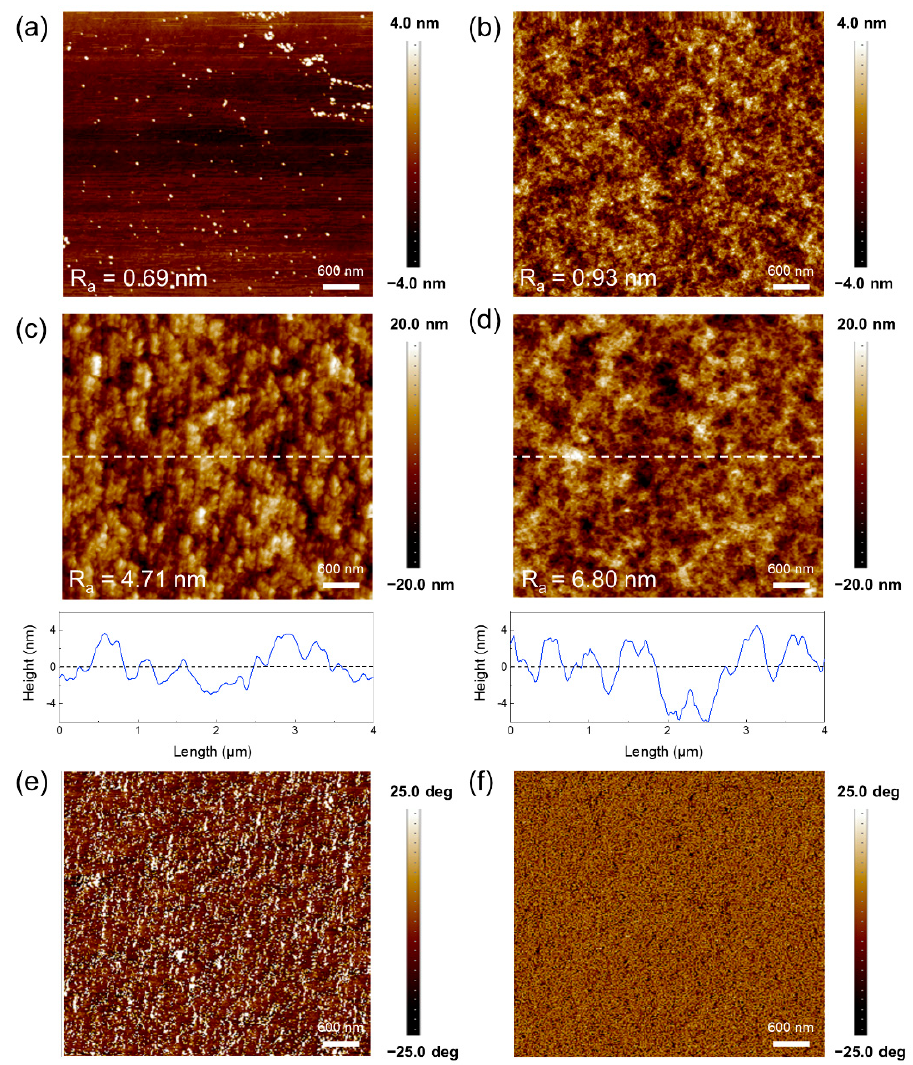
Figure 5. AFM surface morphology images of ( a ) glass and ( b ) PET substrates. AFM surface morphology images and surface lines of the inkjet-printed 4-layer PEDOT:PSS electrodes on ( c ) glass and ( d ) PET substrates. Phase image of the inkjet-printed 4-layer PEDOT:PSS electrodes on ( e ) glass and ( f ) PET substrates.